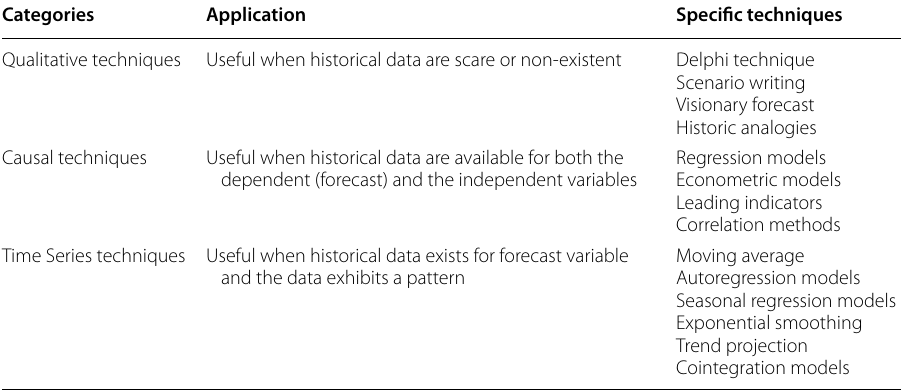
Table 1 Time series forecasting techniques